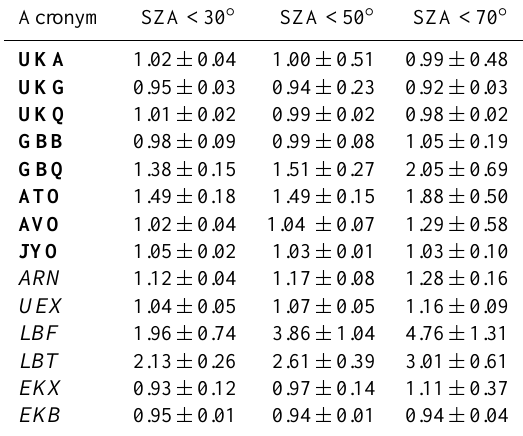
Table 3. Statistics of ratios between QASUME and all array spec- troradiometers regarding the UV index: the numbers indicate the averaged ratios within the selected range of solar zenith angles (SZAs), with their corresponding deviation from the